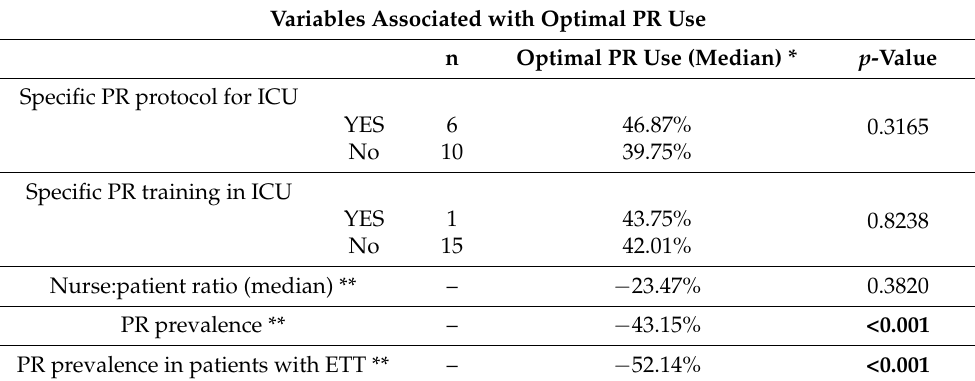
Table 9. Variables associated with optimal use of physical restraints. Variables Associated with Optimal PR Use n Optimal PR Use (Median) * p -Value Specific PR protocol for